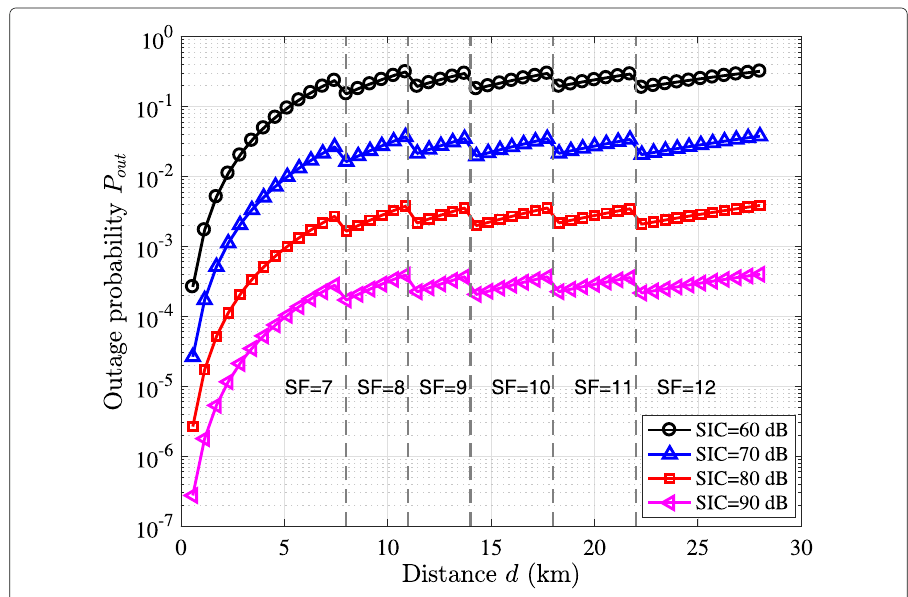
Fig. 3 Outage probability of FDQ-LoRa, in the sub-urban environment ( α = 2.7)